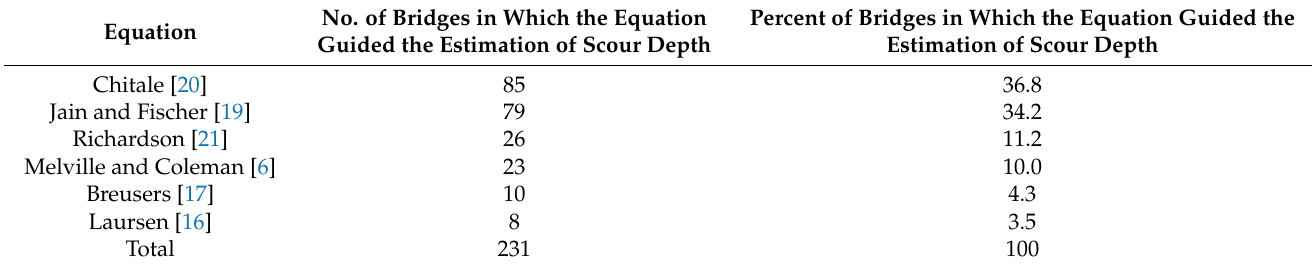
Table 1. Summary information on the equations guiding the design scour